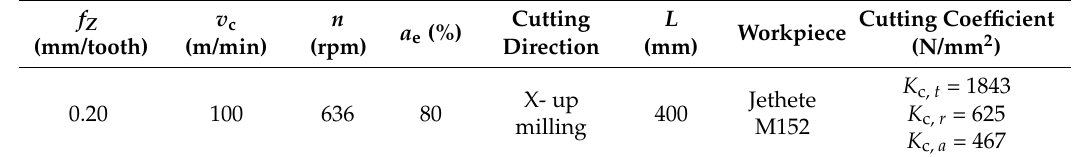
Table 2. Process conditions.